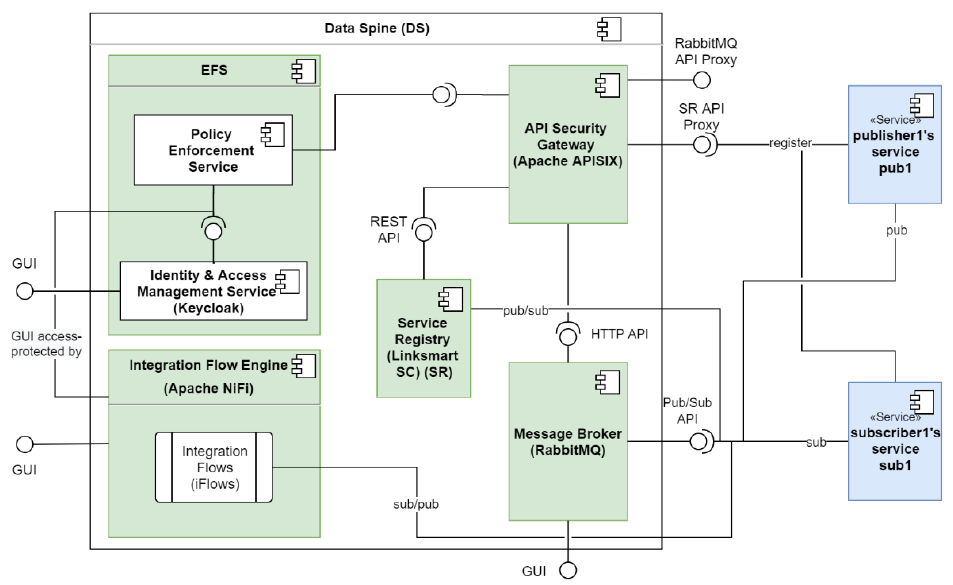
Figure 11. Asynchronous services’ integration through Data Spine.